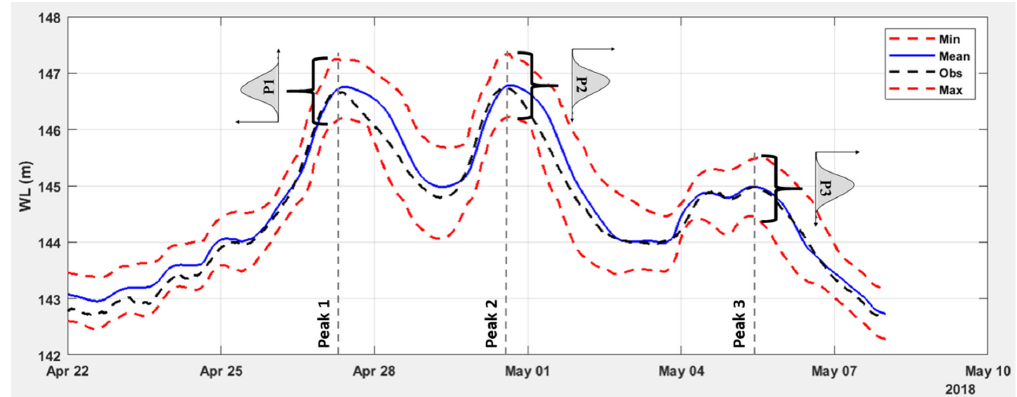
Figure 11. Location of the peak flow analysis on a typical generated hydrograph for the considered event V2. event